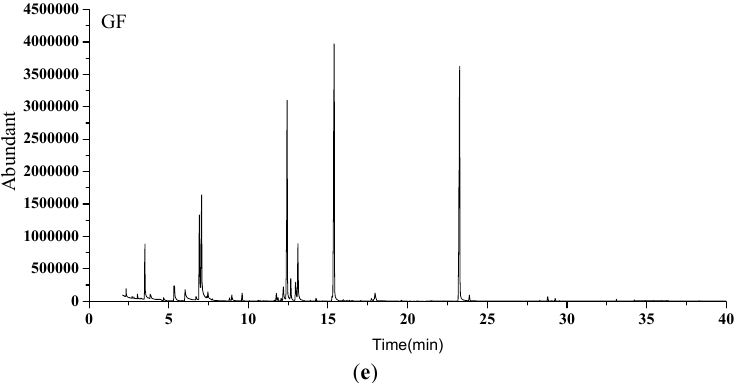
Figure 2. The representative Total ion chromatograms of five varieties mango samples. a : QM, b : JM, c : HY, d : TN, e : GF.